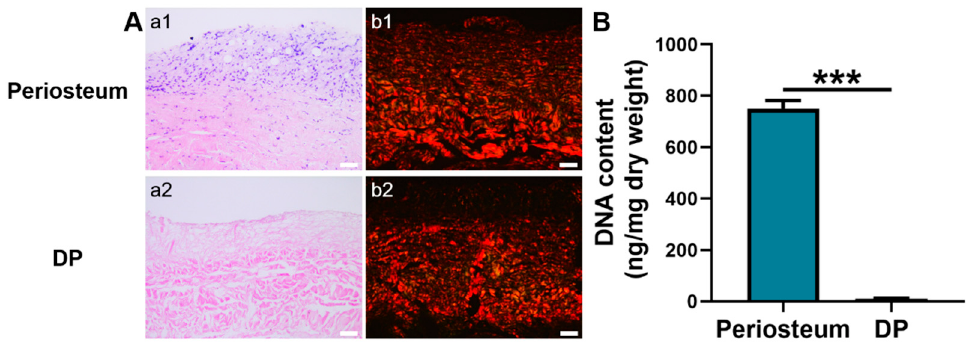
Figure 1. Characterization of periosteum and DP. ( A ) Histological analysis. a1–a2 H&E staining. b1–b2 Picrosirius red staining. ( B ) DNA content quantification. Scale bar = 50 µ m. *** p < 0.001.